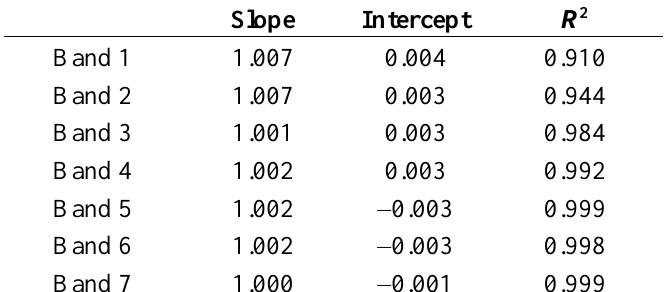
Table 3. Linear regression analyses of cloud-free pixels before and after the algorithm.